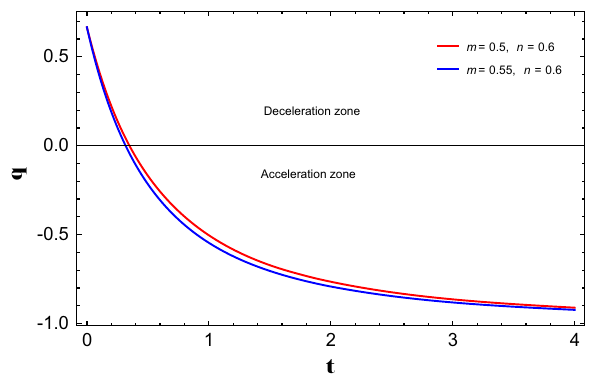
Fig. 1 Deceleration parameter evolution in